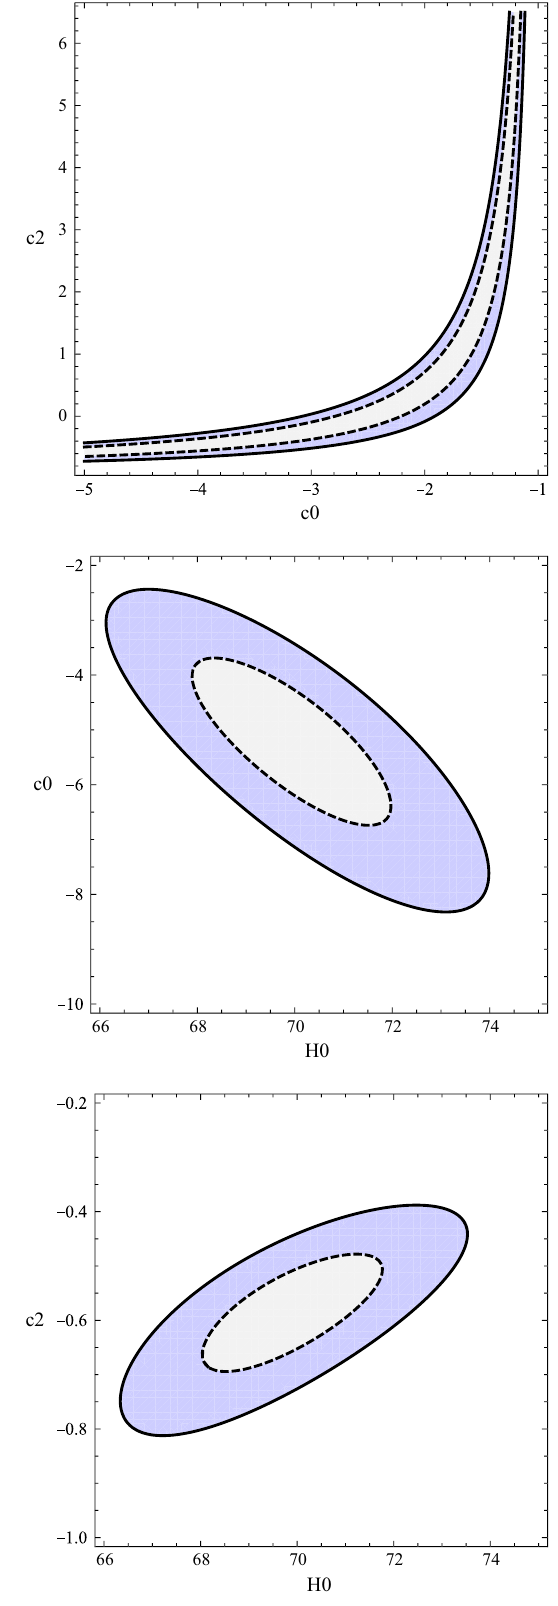
Fig. 1 Contours at 1 σ and 2 σ over the free parameters of our